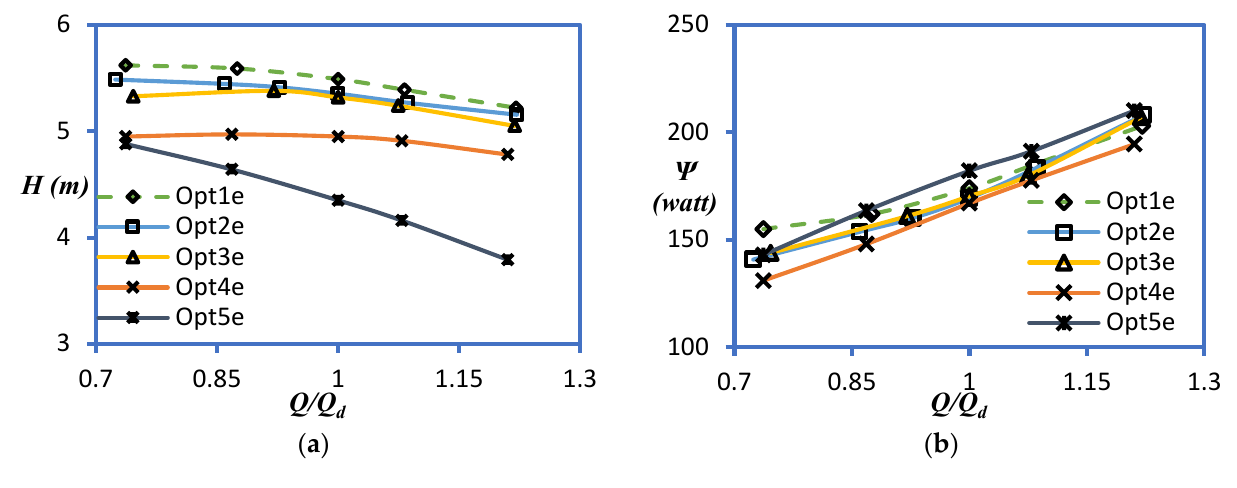
Figure 26. Effect of oil viscosity on pump performance curves for optimized design of maximized head rise: ( a ) head rise ( H ) vs. Q/Q d and ( b ) input power ( Ψ ).